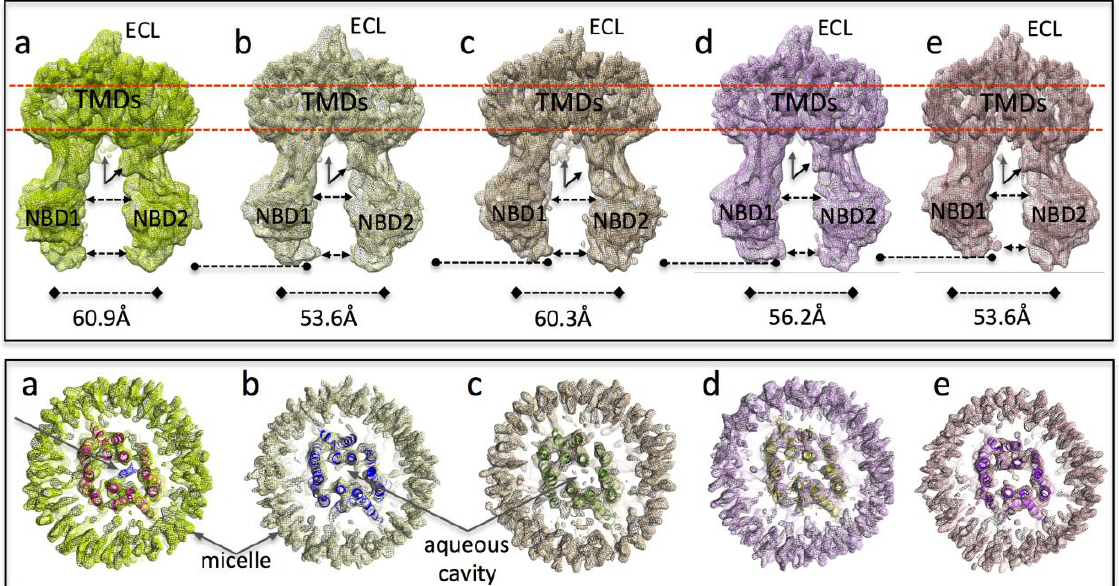
Figure 1 . Differentiation of the five 3D maps ( a – e ): Maps are displayed at a density level enclosing a volume of 153,000 Å 3 . Upper panel: (1) NBD1 rotates and hinges upwards towards the TMDs; with this increasing from maps ( a ) through to ( e ), (dashed line with circles indicates the lower edge of NBD1). (2) NBD1-NBD2 separation, (dashed lines with arrowheads) is greatest for map ( a , c ), least for map ( e ) and intermediate for maps ( b , d ). (3) Density for the N-terminus (rearwards, vertical arrow) and the end of the NBD1-NBD2 linker (slanted arrow, front) is present in map ( a ), whilst other maps lack the N-terminus density (maps ( b , d )) or lack the linker density ( c ). (4) The density for the extracellular loop (ECL) between TM helices 1 and 2 is weaker for maps ( c , e ). Lower panel: slices through the transmembrane regions of the maps (as indicated by the red dashed lines in the upper panel). Real-space refined atomic models that were generated are also displayed using ribbon representation in contrasting colors. The diameter of the micelles in maps ( a , c ) are larger; map ( e ) has the smallest micelle with some distortion from circular. Map ( a ) contains a central density (blue mesh, arrow) not accounted for by the real-space refined model. Other maps have only small features in the aqueous central cavity. Map ( e ) shows the most compact transmembrane organization.